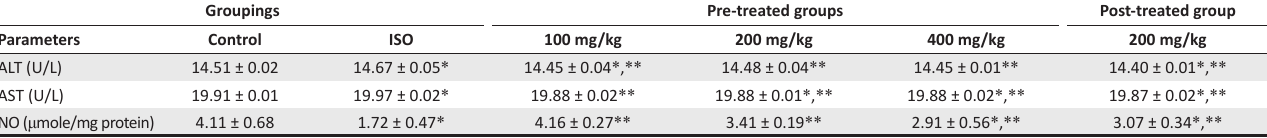
Note: Values are presented as mean ± standard deviation. * , indicates significant difference ( p < 0.05) when compared with control (Grp A); ** , indicates significant difference ( p < 0.05) when compared with ISO treated only (Grp